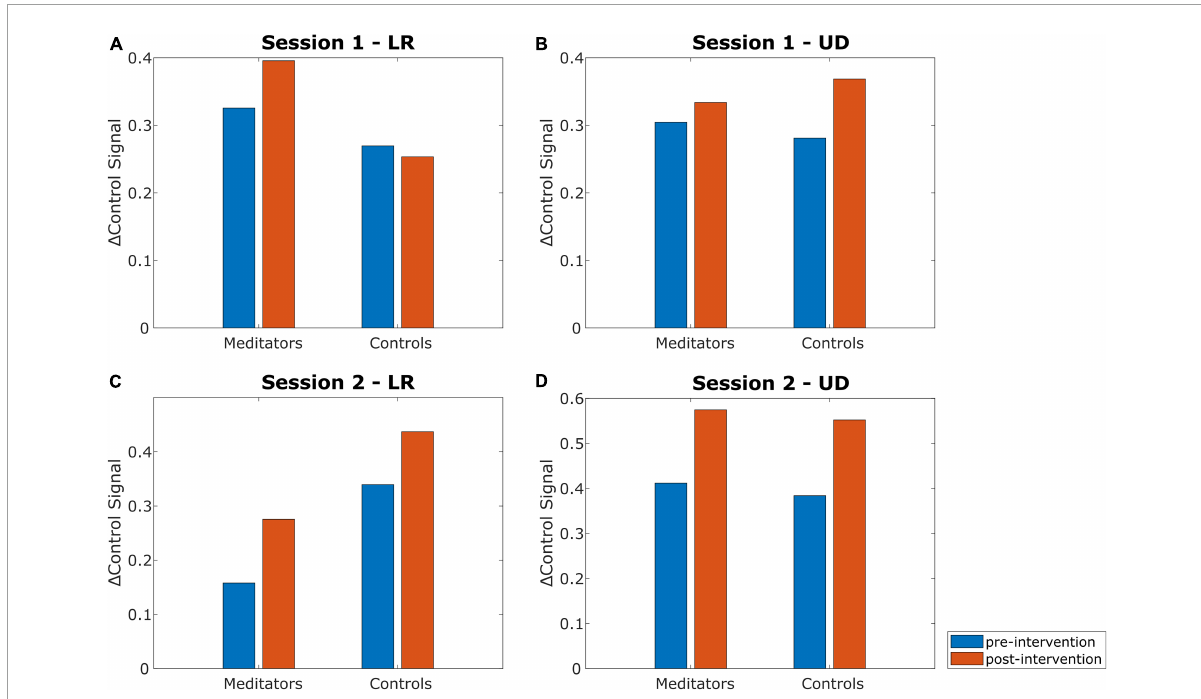
FIGURE6 Changes in the (cid:52) control signal for the LR and UD tasks in both sessions. Session 1 meditators are from group MC ( n = 10) and control subjects are from group CM ( n = 11). Session 2 meditators are from group MM ( n = 10) and control subjects are from group MC ( n = 10). Within-session changes and inter-group differences were analyzed using the Wilcoxon signed-rank and Wilcoxon rank-sum test, respectively. None of the comparisons (pre- vs. post-intervention, meditators vs. controls) showed statistically significant difference. (A) Changes in the (cid:52) control signal for the LR task in session 1. (B) Changes in the (cid:52) control signal for the UD task in session 1. (C) Changes in the (cid:52) control signal for the LR task in session 2. (D) Changes in the (cid:52) control signal for the UD task in session